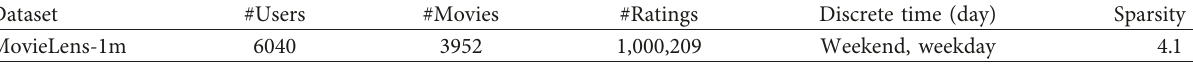
Table 1: The statistics of experimental dataset.